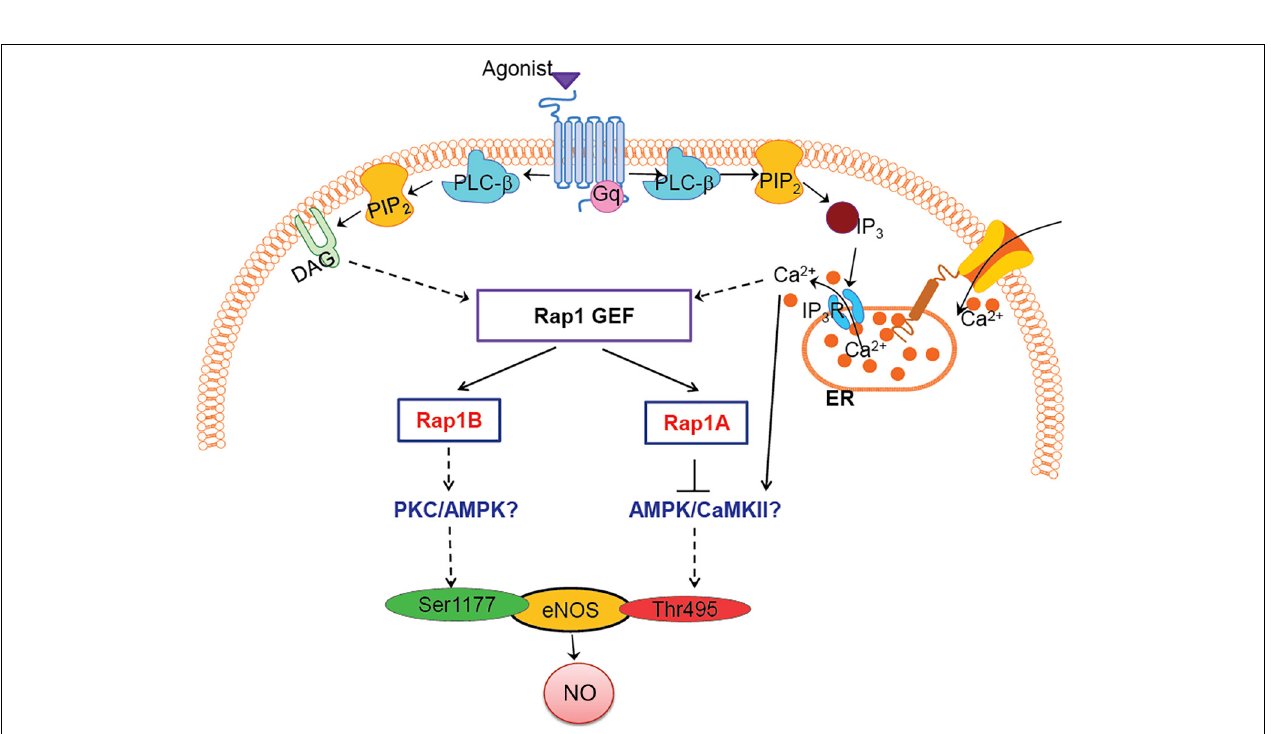
FIGURE 4 | Model: how Rap1A, Rap1B contribute to NO release, role in agonist-induced eNOS activation. Two Rap1 isoforms regulate eNOS activity via distinct signaling pathways; Rap1B promotes eNOS, activating Ser1177 phosphorylation, while Rap1A suppresses Thr495 eNOS phosphorylation, preventing eNOS inhibition. Candidate kinases regulated by Rap1 isoforms, PKC/AMPK/CaMKII, are indicated in blue font.